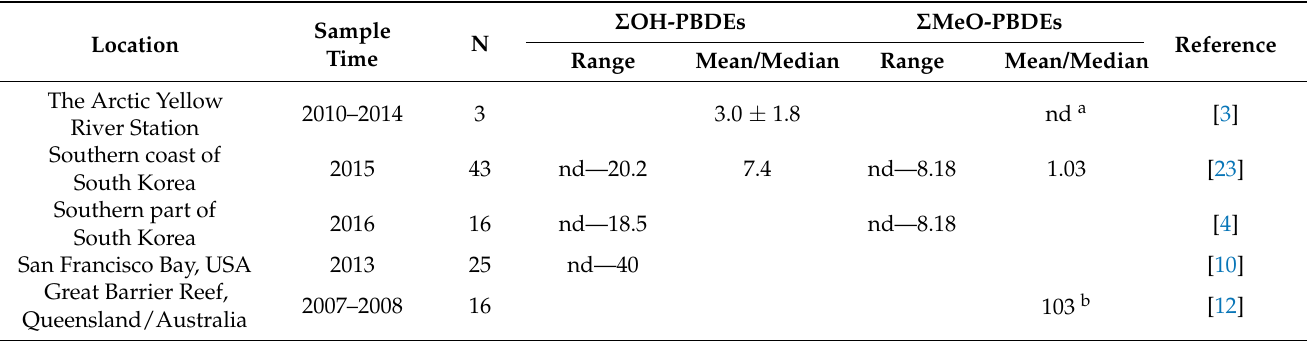
Table 1. Concentrations of OH/MeO-PBDEs in seawater